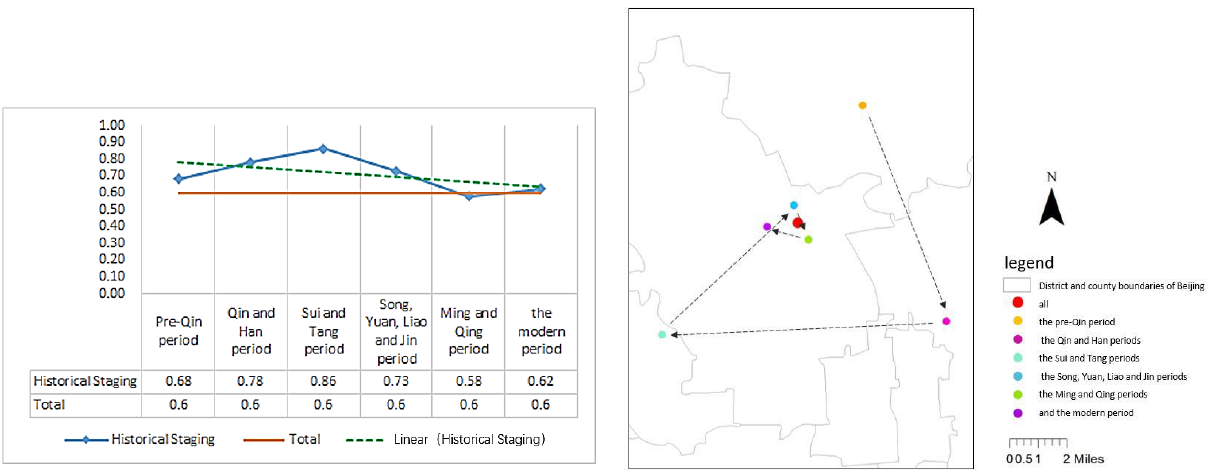
Figure 7. Standard deviation ellipse eccentricity of Beijing's cultural heritage units.